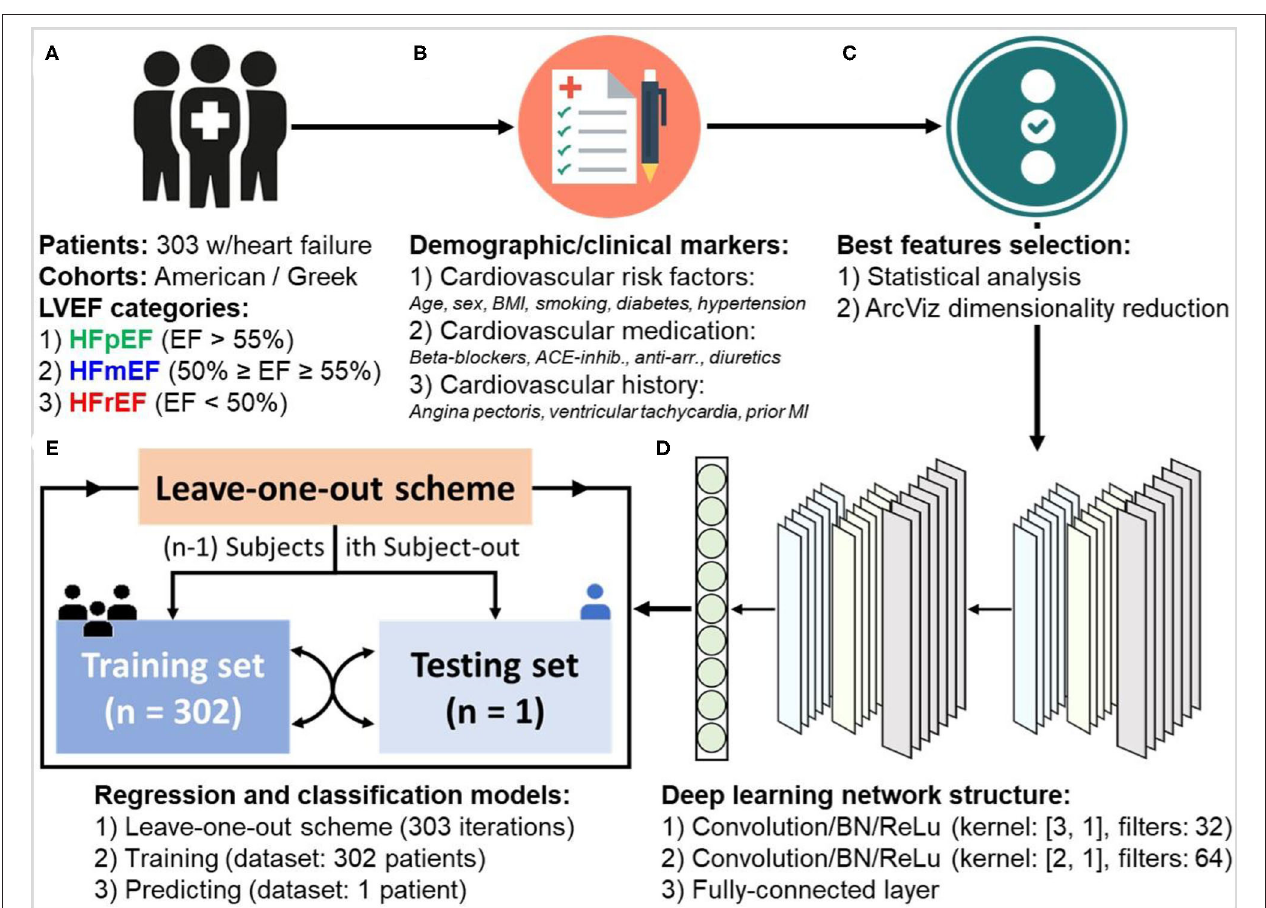
FIGURE 1 | Workflow of developing deep learning-based regression and classification models for the prediction of left ventricular ejection fraction (LVEF) levels and categories in heart failure patients. The procedure goes through: (A) dataset collection ( n = 303 patients), (B) patient information and demographic/clinical markers categorization, (C) statistical analysis of markers and dimensionality reduction using ArcViz (feature selection), (D) designing deep learning network structure, and (E) development of regression and classification models with leave-one-out training and predicting